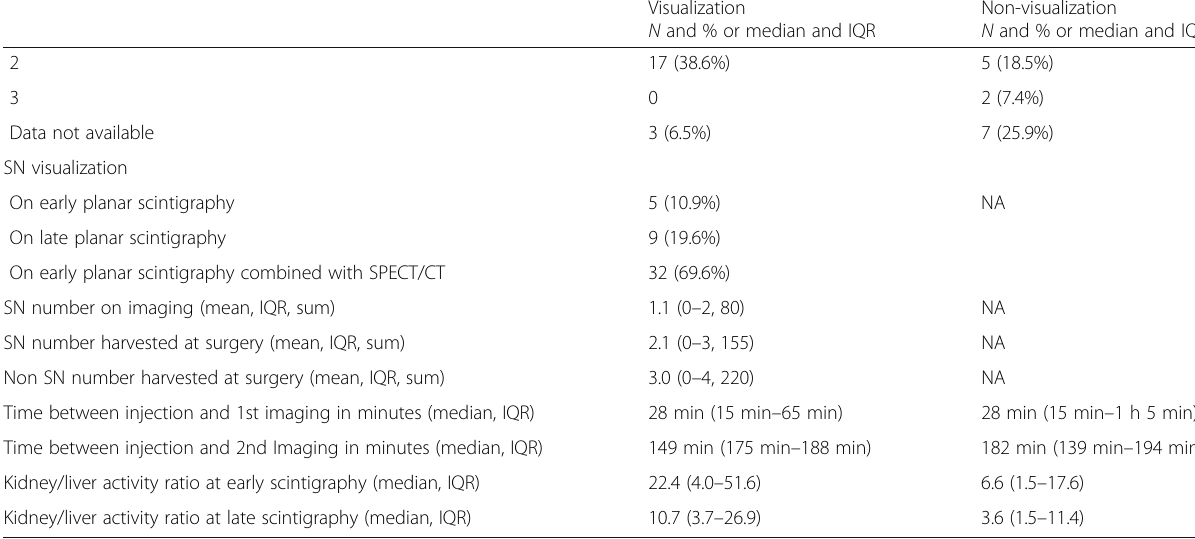
Table 2 Patient and procedure characteristics for visualization and non-visualization (Continued)